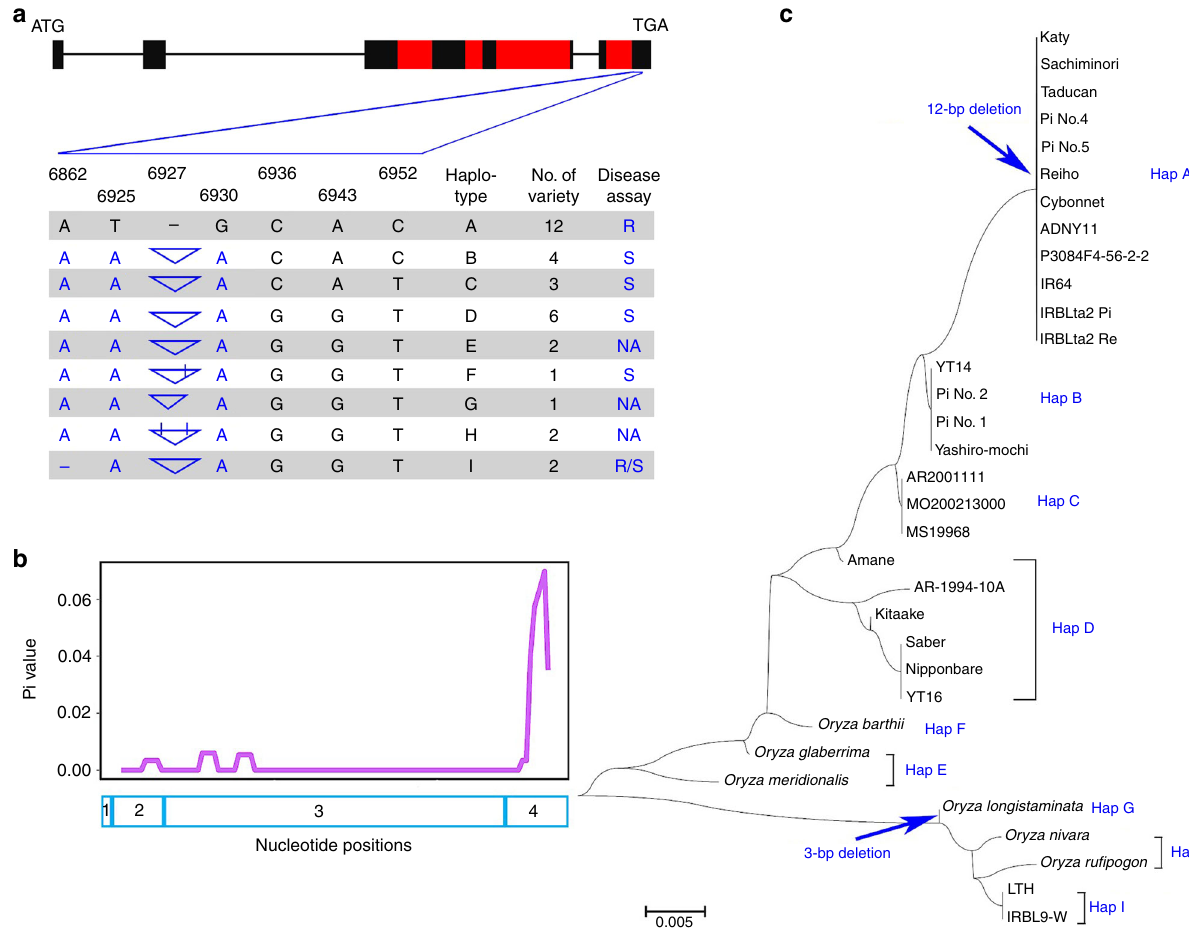
Fig. 4 Ptr gene variation within Oryza species. The DNA sequences from the fourth exon of Ptr in cultivated rice and wild rice relatives were used to construct a phylogenetic tree. All the DNA sequences of the wild rice relatives were downloaded from the Gramene website (www.gramene.org). a Natural variation in Ptr . The haplotype was determined based on fi ve nonsynonymous and 12 bp InDel differences between Katy and Amane in addition to one InDel in front of a 12 bp InDel resulting in a frame-shift of Ptr . Exons are indicated by black fi lled rectangles and Armadillo (ARM) repeats (Superfamily 1.75) are indicated by the red fi lled rectangles. In the table, the triangles indicate the insertion and width of triangles indicate the insertion size. The black lines in the triangles indicate that the nonsynonymous substitution occurred inside of the 12 bp. NA means data is not available. b Sliding window of nucleotide variations in the Ptr ORF. The blue rectangles indicate the number and position of each exon. c Phylogenetic tree of Ptr in Oryza species (Supplementary Fig. 8). Hap A corresponds to Pi-ta / Pi-ta2 / Ptr -containing varieties and Hap B corresponds to Pi-ta -containing rice varieties. Microscale units are